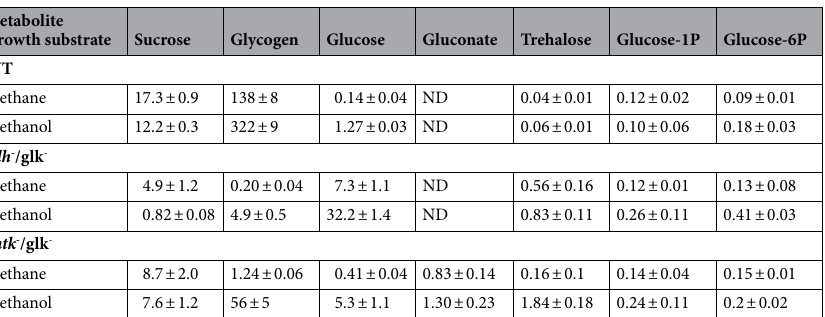
Table 3. Accumulation of carbohydrates (mg per g of DCW) in the wild type (WT) cells of Mtm. alcaliphilum and mutant strains deficient in glucose dehydrogenase/glucokinase ( gdh - / glk - ) and gluconate kinase/ glucokinase ( gntk - / glk - ). ND , not detected. The samples for analyses were drawn at late exponential phase of the culture